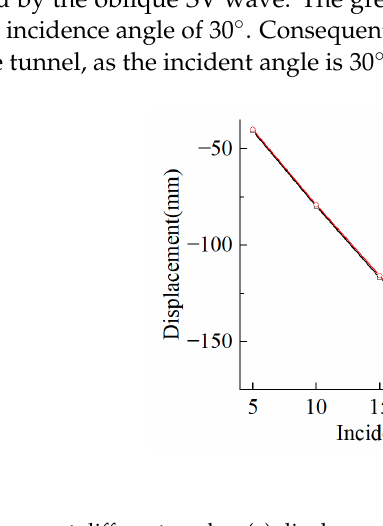
Figure 8. Vertical displacement curves at different angles: ( a ) displacement curves of section 1 ‐ 1 and ( b ) displacement curves of section 6 ‐ 6.